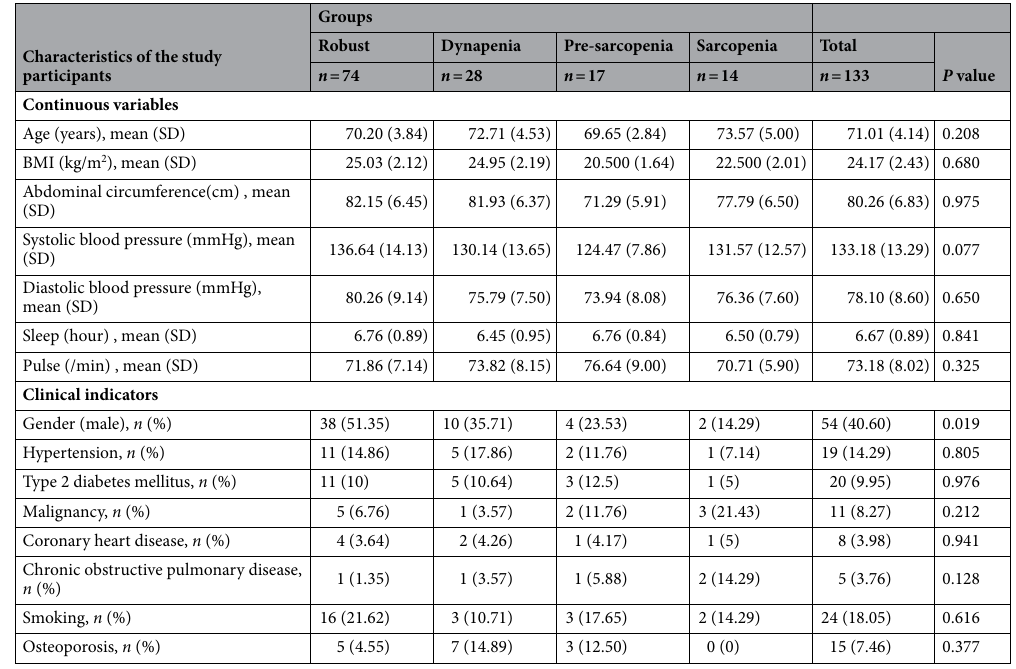
Table 1. Characteristics of the study subjects in the robust, dynapenia, presarcopenia, and sarcopenia groups. Differences were tested using one-way ANOVA.